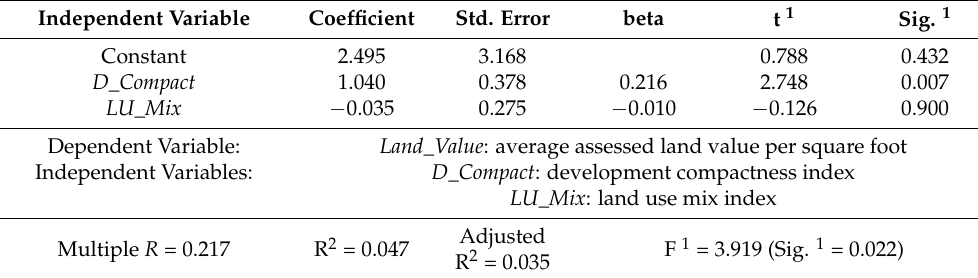
Table 5. Regression analysis of land value on development compactness and land use mix ( N =